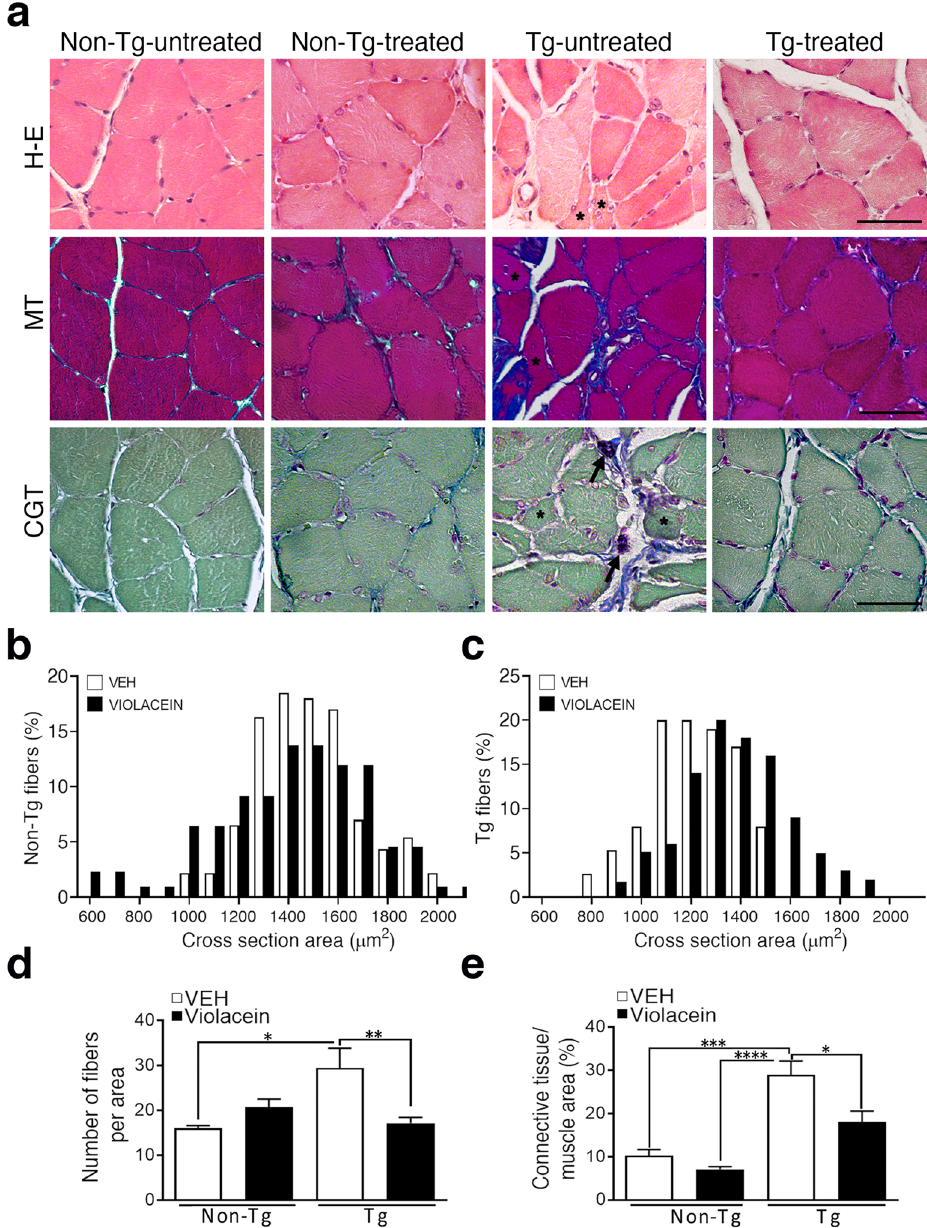
Figure 3. Histological analysis of muscle soleus upon violacein treatment. ( a ) Representative light images of cross-sectional muscle fibers stained with hematoxylin–eosin (H&E) and Masson (MT) and Cajal-Gallego (CGT) trichromes from each experimental group. Non-Tg animals showed muscle fibers of similar size and morphology and ordered collagen (blue staining in MT or CGT). Instead, Tg-untreated condition presented atrophic fibers (asterisks), fibrosis evidenced by abundant disordered collagen fibers and mastocytes (black arrows in CGT staining) close to atrophic fibers indicating clear pathological signs. The Tg-treated condition showed minor pathological signs as indicated by less atrophic fibers, decreased collagen areas and general appearance closer to that of Non-Tg conditions. Calibration: 50 μm. ( b , c ) Distribution of soleus cross sectional areas in Non-Tg ( b ) and Tg ( c ) -untreated (vehicle, white columns) and -treated (violacein, black columns) rats showing in Tg-treated animals a displacement of the fiber size frequency peak toward the bigger values. ( d ) The number of fibers per area were increased in Tg-untreated related to Non-Tg (p = 0.0338) or Tg-treated rats (p = 0.0099). Non-Tg and Tg-treated values were similar (p = 0.2229). ( e ) Quantitative analysis of MT stain evidenced increased collagen in Tg-untreated when compared with Non-Tg (p = 0.0007) or with Tg-treated rats (p =